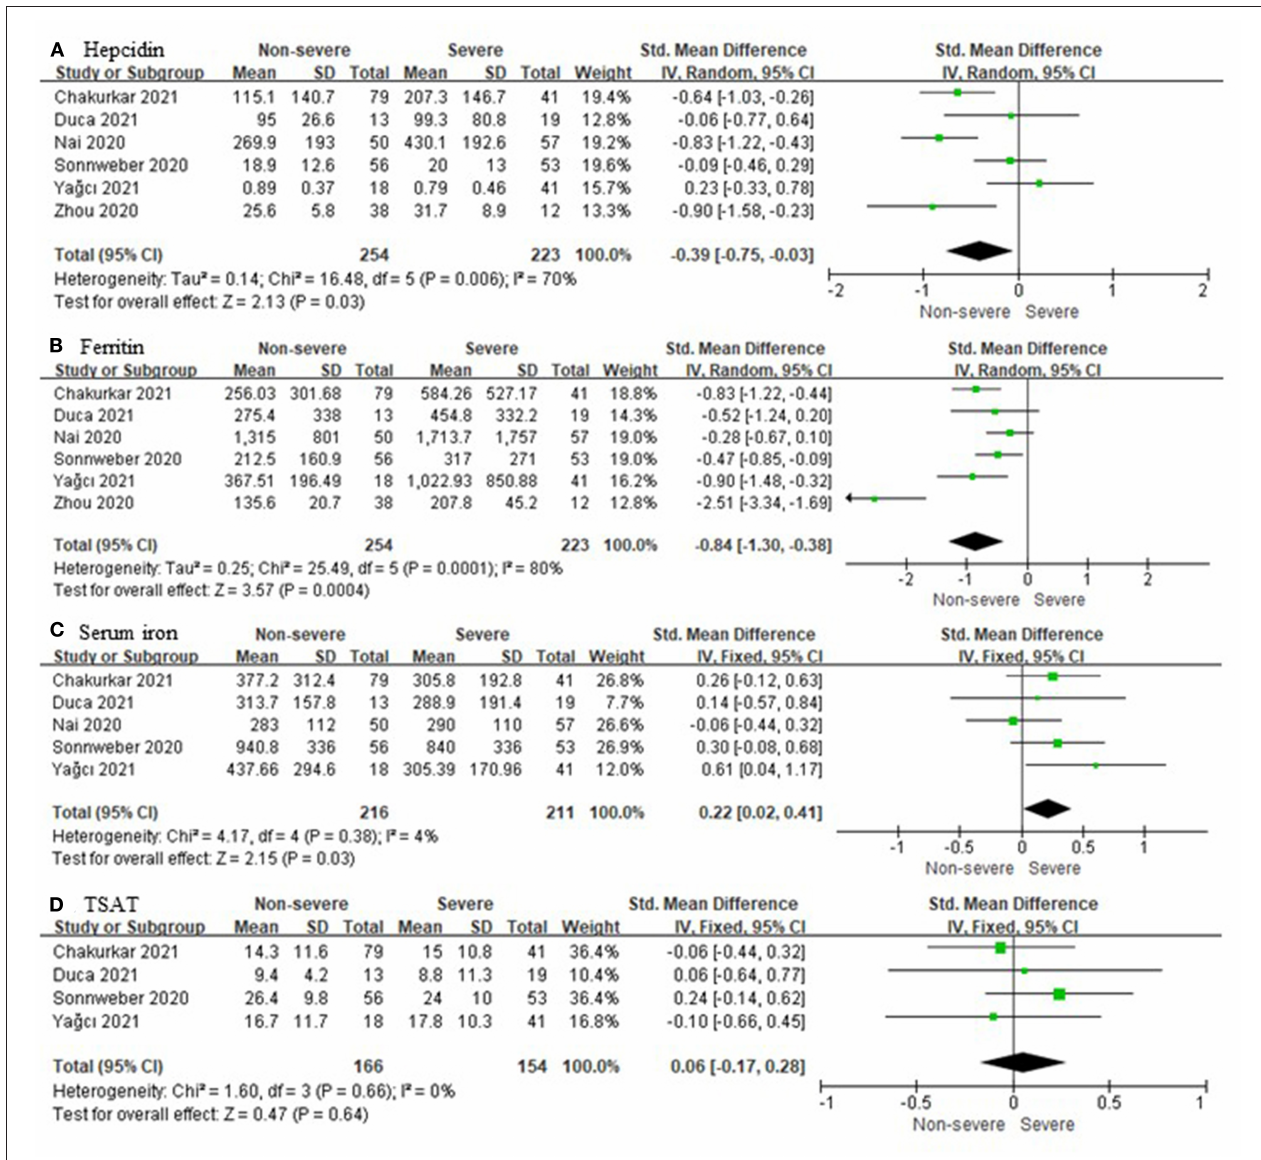
FIGURE 2 | Comparison of iron metabolism parameters between non-severe and severe COVID-19 cases. (A) Hepcidin; (B) Ferritin; (C) Serum iron; (D) Transferrin saturation (TSAT).